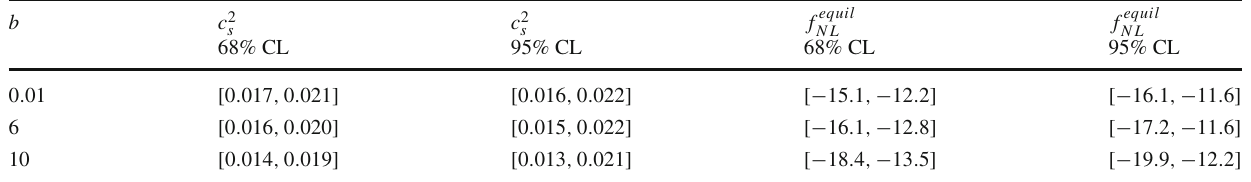
Table 2 The prediction of the model for the equilateral amplitude of the non-Gaussianity, obtained from the observationally viable values of the parameter β at 68% CL and 95%